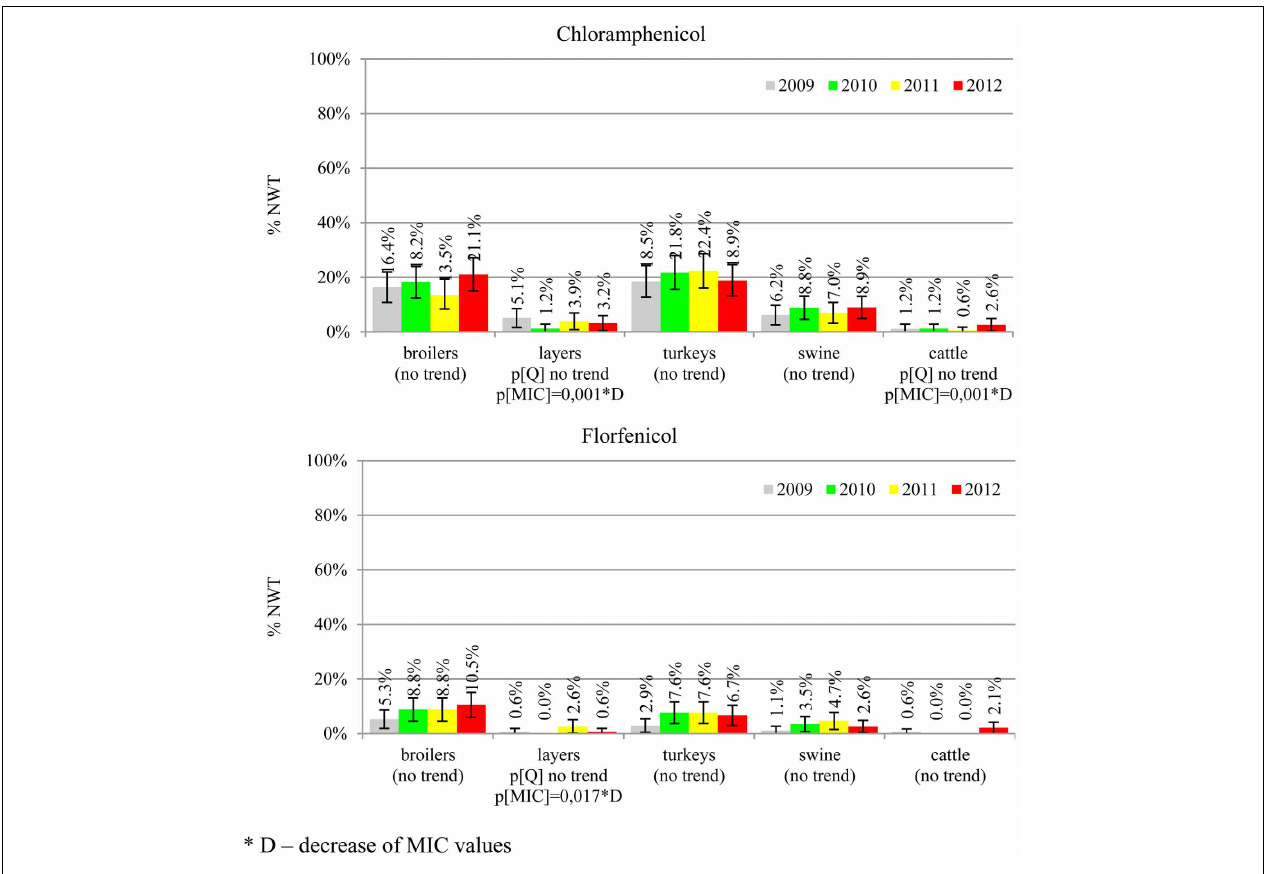
FIGURE 3 | Microbiological resistance to